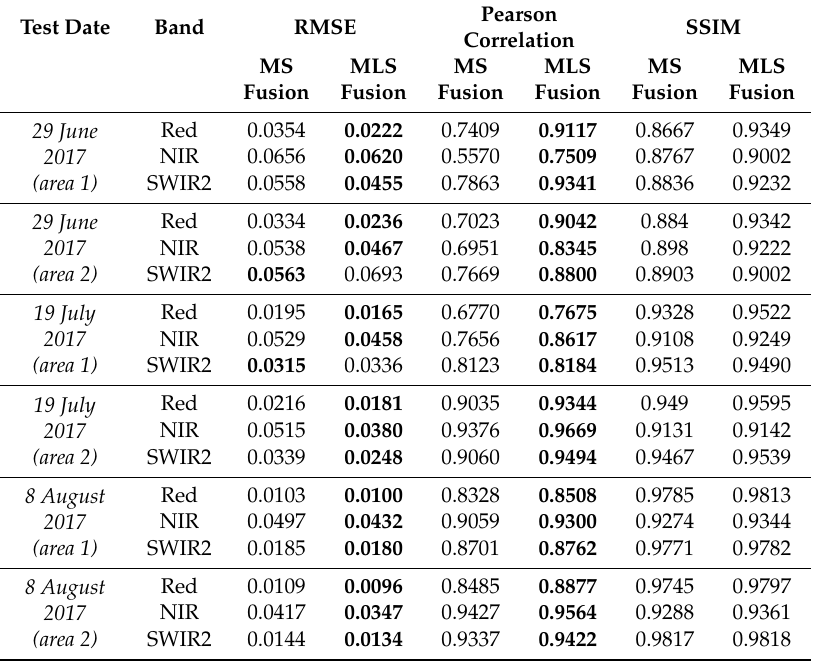
Table 2. Quantitative assessments of STAIR 2.0 fusion. Three observed Sentinel-2 images on 29 June, 19 July and 8 August 2017 were held out as the ground truth image to assess the fusion results of STAIR 2.0. For each image, two areas were randomly sampled as the test areas. Two fusion settings, MODIS–Sentinel (MS) and MODIS–Landsat–Sentinel (MLS), were compared. Pearson correlation, root-mean-square error (RMSE), and structural similarity (SSIM) were used as the evaluation metrics. Results of red, NIR, and SWIR2 bands are shown. For each test band, the better performance (lower RMSE, higher correlation, or higher SSIM) is in bold. See Table S1 for the results of other bands (green, blue, and